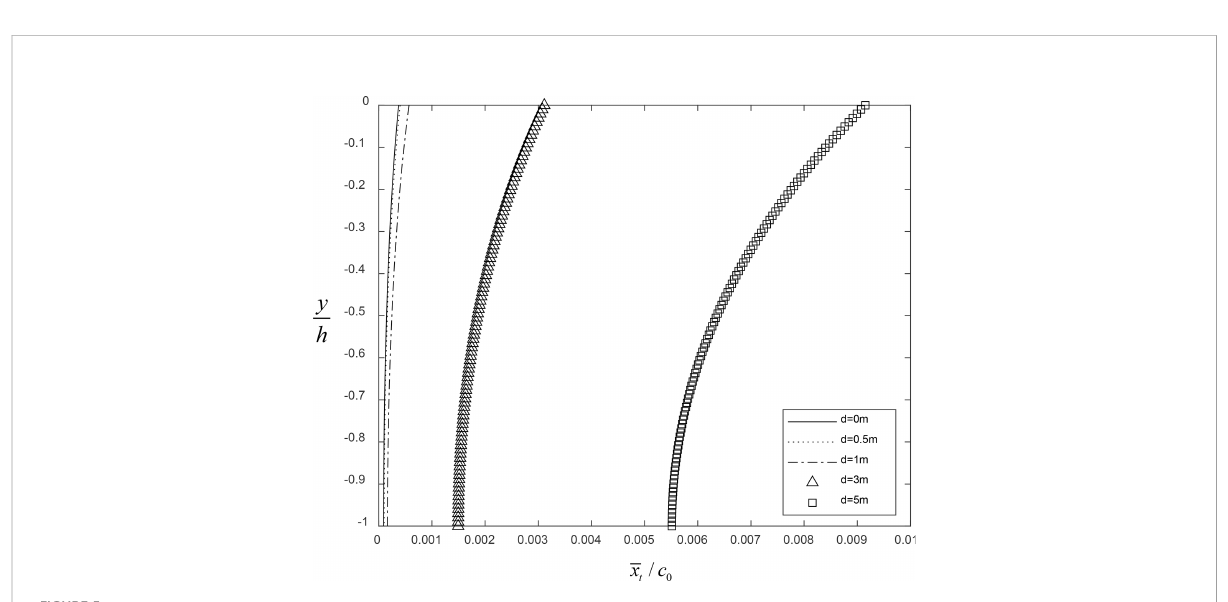
FIGURE 5 Dimensionless mass transport velocity versus vertical labels b for water depth h = 50 m under various thicknesses of the ice sheet d = 0, 0.5, 1, 3, 5